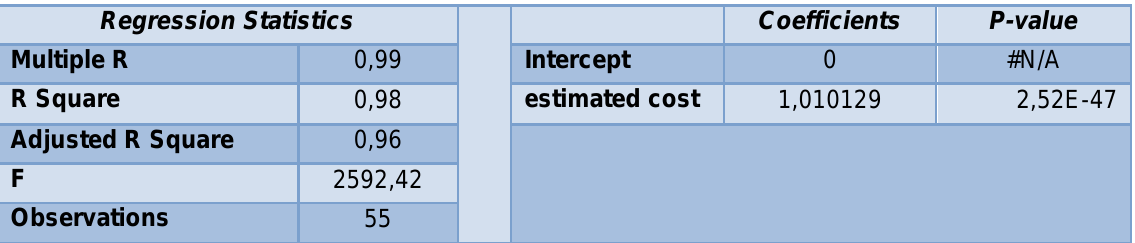
Table 7 Regression statistics of estimated cost vs. actual cost in road projects with cost more than